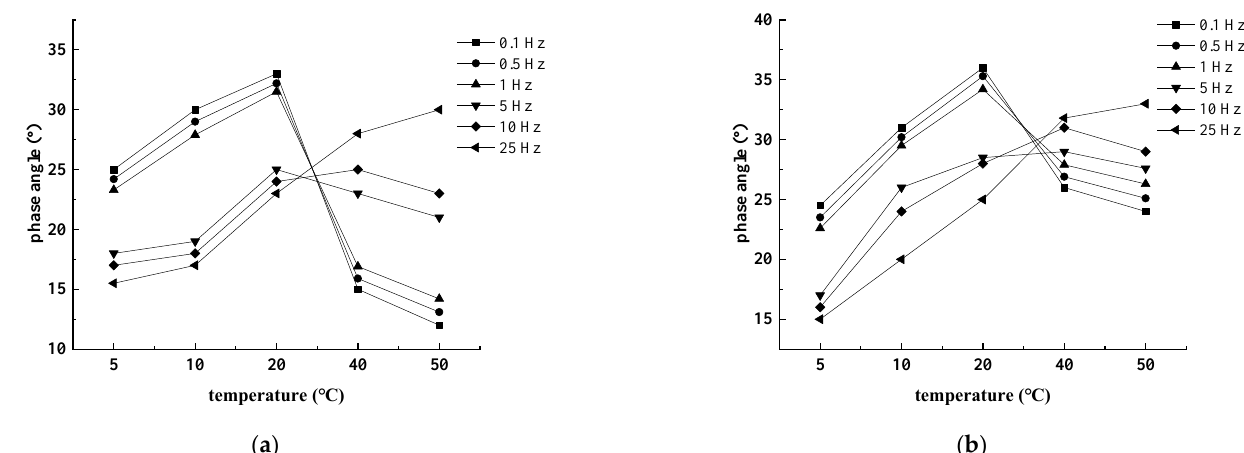
Figure 13. Relationship between the phase angle and temperature of different asphalt mixtures: ( a ) rubber-powder-modified asphalt mixture; ( b ) SBS-modified asphalt mixture.